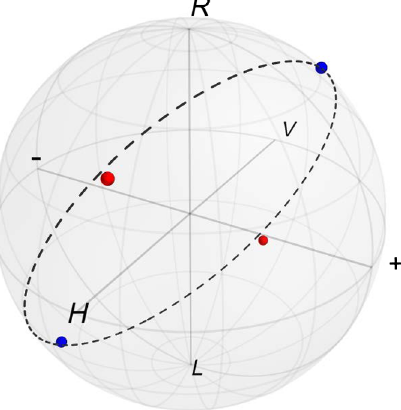
10. Measured polarization states on Bloch sphere. The dots represent the produced states by the polarization modulator in chip.